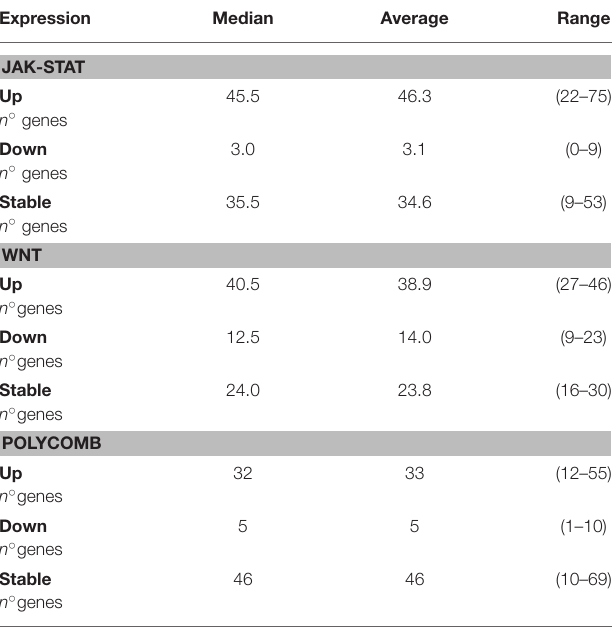
TABLE 3 | Number of de-regulated